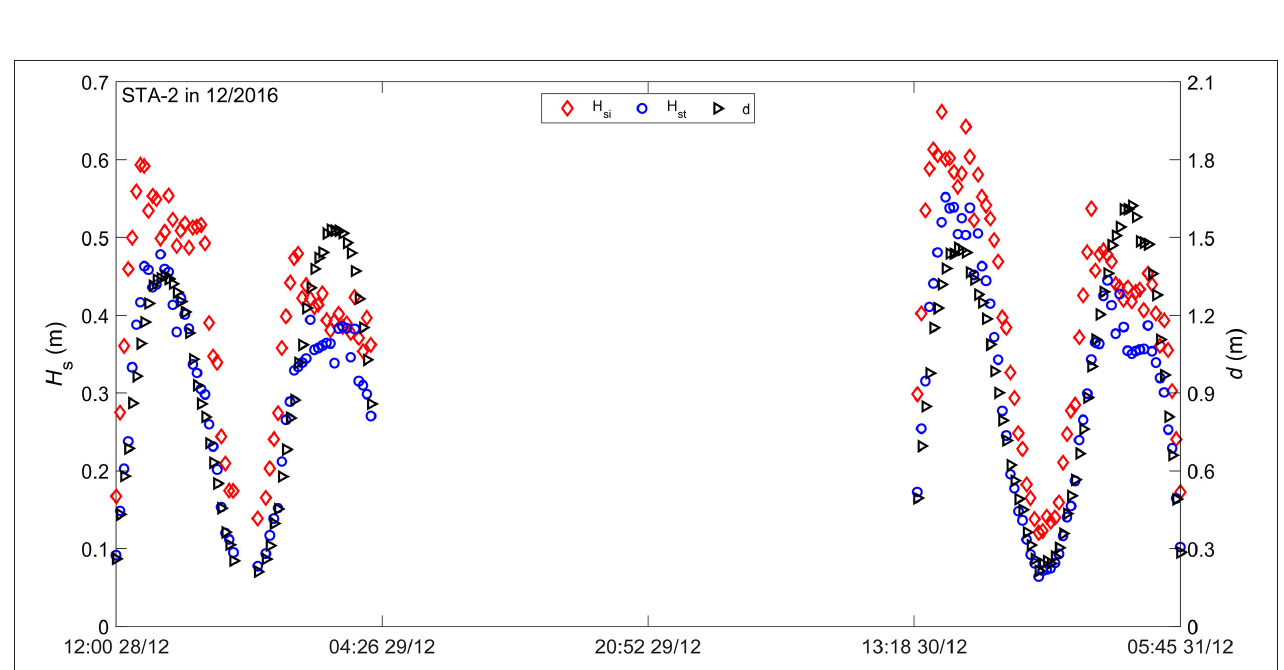
FIGURE 5 | Significant wave heights ( H si and H st ) and water depth at station STA-2 in 12/2016.